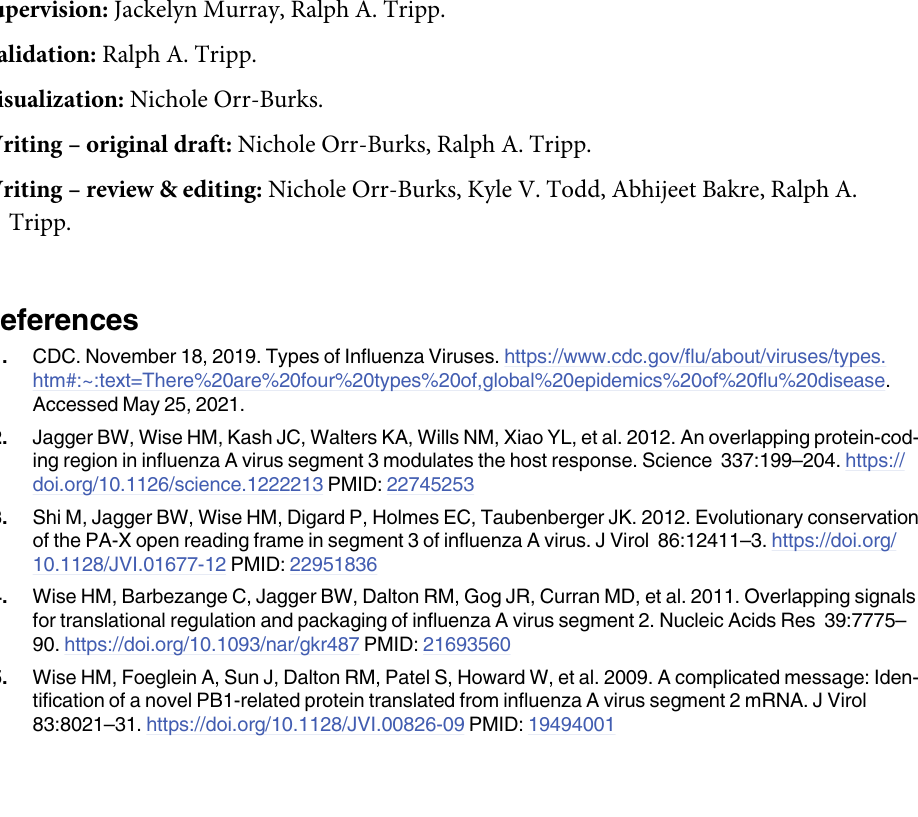
S3 Fig. Triamterene does not reduce Calu-3 viability. CellTiter Blue non-destructive assay was used to evaluate changes in cell viability of CALU-3 cells following 48h treatment with Triamterene following a replenishment protocol where drug and media were replaced at 24h. Data is presented as mean of percentage of DMSO treated control ± standard error (Mean ± SEM). Toxicity is defined as > 20% loss of viability compared to mock control. Aster- isks indicate significant differences from the DMSO treated control by ordinary one-way anal- ysis of variance with Dunnett’s multiple-comparison test (P <